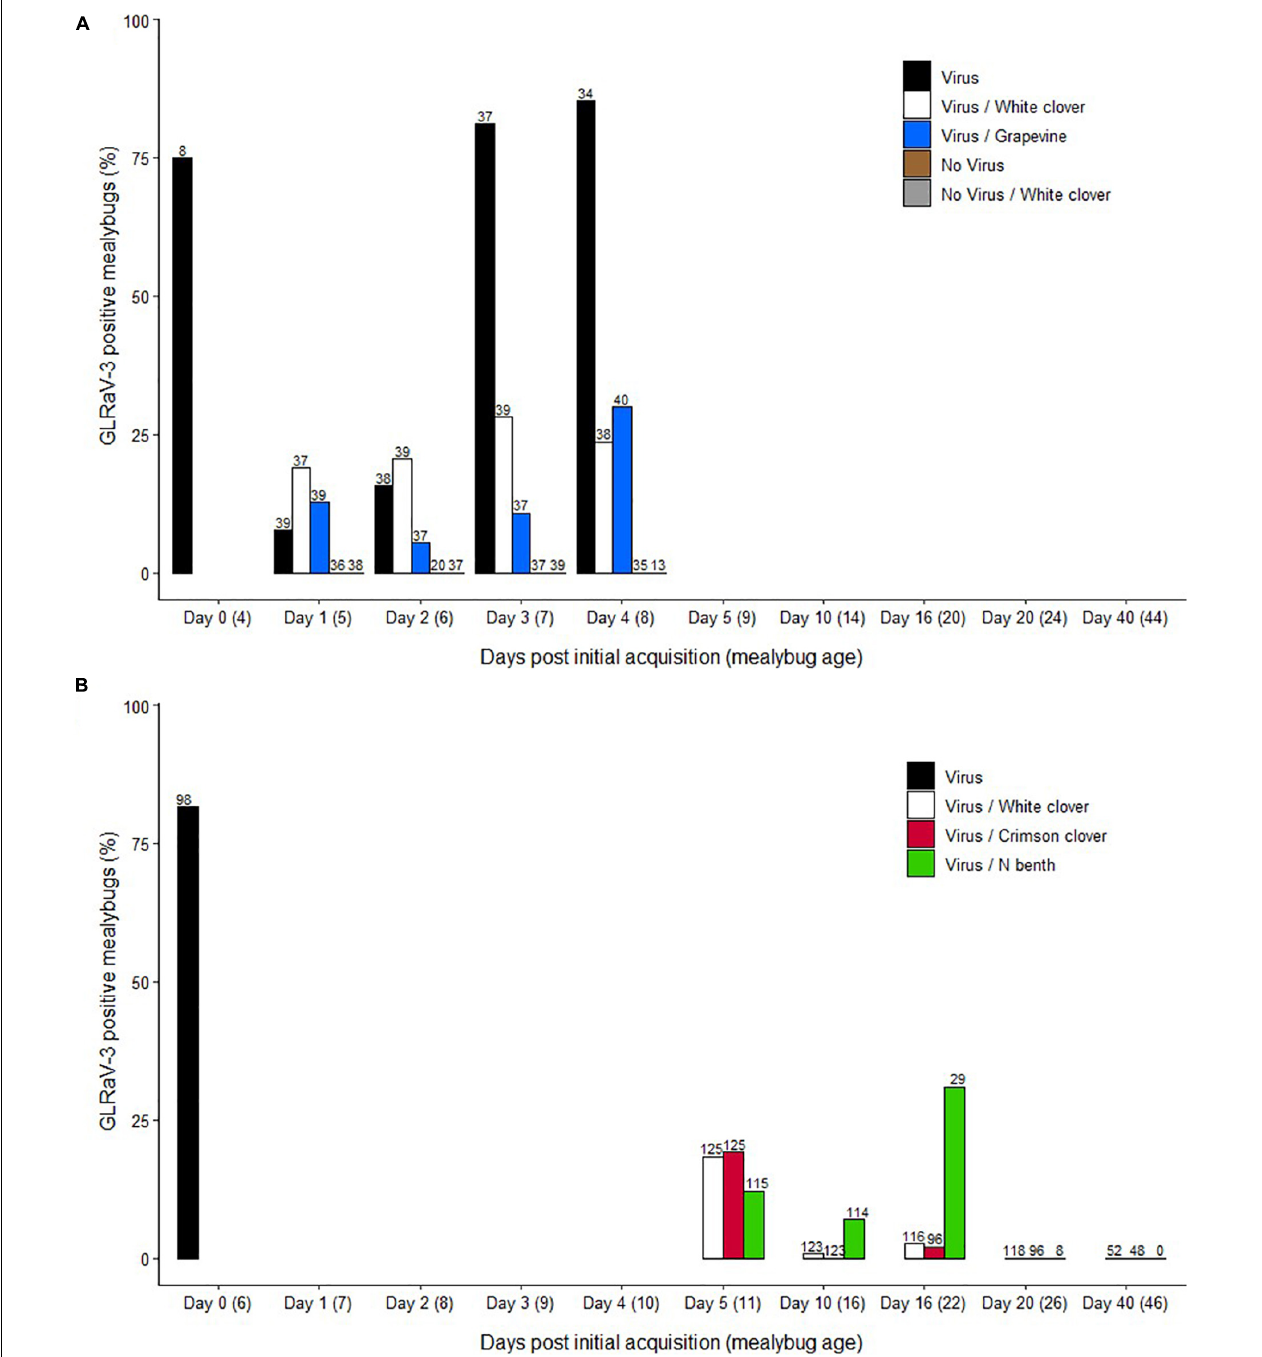
FIGURE 1 | Retention of grapevine leafroll-associated virus 3 (GLRaV-3) in Pseudococcus calceolariae after feeding on non- Vitis plant host based on results from experiments conducted in (A) 2015 and (B) 2020. (A) Day 0 (Virus acquisition): First instar nymphs had a 4 days acquisition access period (AAP) on GLRaV-3 positive grapevine leaves, and a sub-sample were tested for GLRaV-3. Days 1–4: Nymphs were transferred to and allowed a 1–4 days access period on White clover ( Trifolium repens L.) (Virus/White Clover) or GLRaV-3 negative grapevines (Virus/Grapevine). As a positive control, mealybugs were left on GLRaV-3 positive grapevine leaves for the duration of the experiment (Virus). Two negative controls were: mealybugs with a 4 days AAP on GLRaV-3 negative grapevine leaves, and then transferred on to White clover (No virus/White Clover) and mealybugs left on GLRaV-3 negative grapevine leaves for the duration of the experiment (No virus). Mealybugs were sampled each day and tested for GLRaV-3. (B) Day 0: First instar nymphs had a 6 days AAP on GLRaV-3 positive grapevine leaves and a sub-sample was tested for GLRaV-3 (Virus). Days 5–40: Nymphs were transferred to allow a 5–40 days access period on Crimson clover ( T. incarnatum ), White clover or Nicotiana benthamiana . Mealybugs were sampled from White clover (Virus/White clover), Crimson clover (Virus/Crimson clover), and N. benthamiana (Virus/N benth) in ∼ 5 days increments and tested for GLRaV-3. Sample numbers (n) are included above each bar.